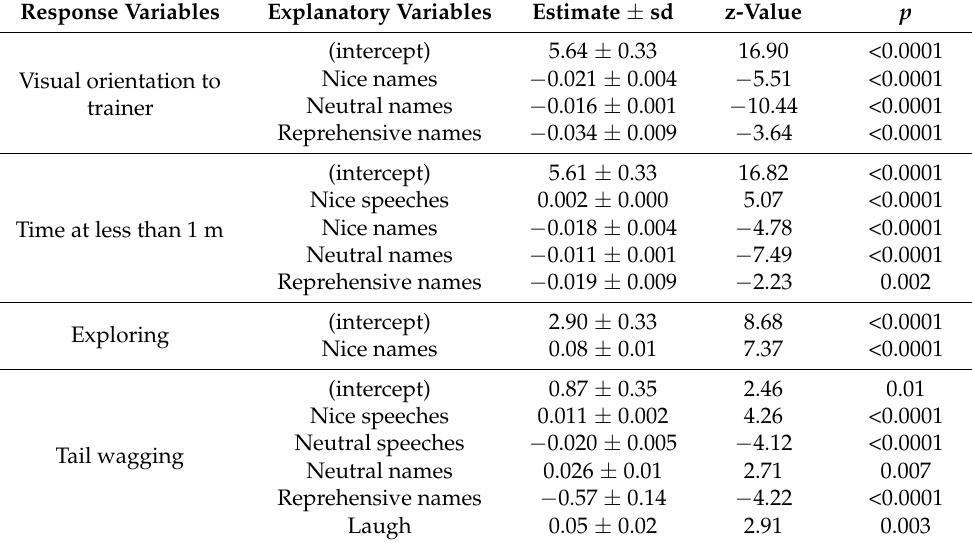
Table 6. Final Generalized Linear Mixed Models * run for wolves ( Canis lupus ), evaluating the effects of the variable nice speeches, nice names, neutral speeches, neutral names, reprehensive names, and laugh on the response variables visual orientation to trainer, time at less than 1 m, exploring, and tail